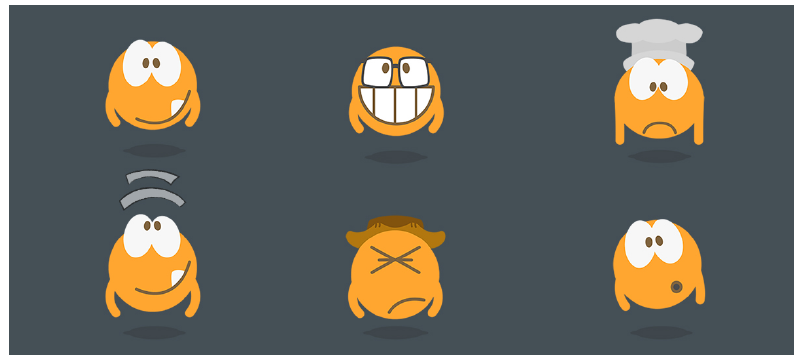
Figure 3. The main character, Vita.